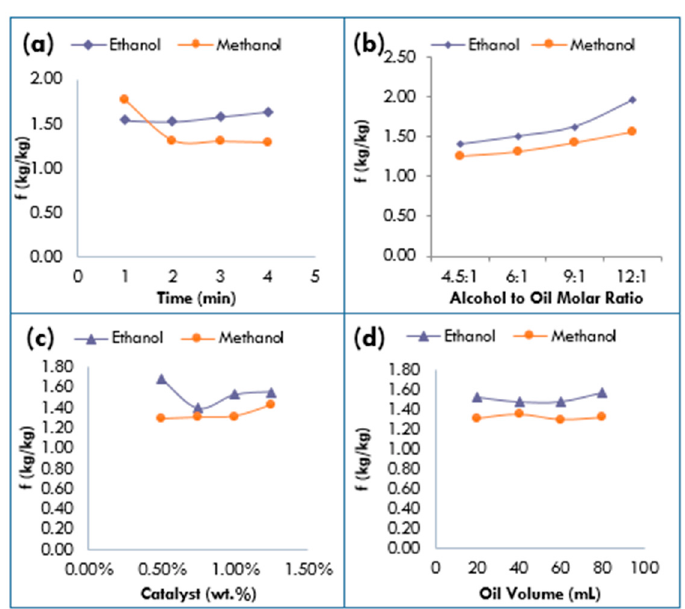
Figure 9. Solvent and catalyst environmental impact parameter (f) for the simultaneous effect of MW/US in WCO transesterification. Effect of ( a ) different reaction time; ( b ) alcohol to oil molar ratio; ( c ) catalyst concentration and ( d ) sample (oil) volume.